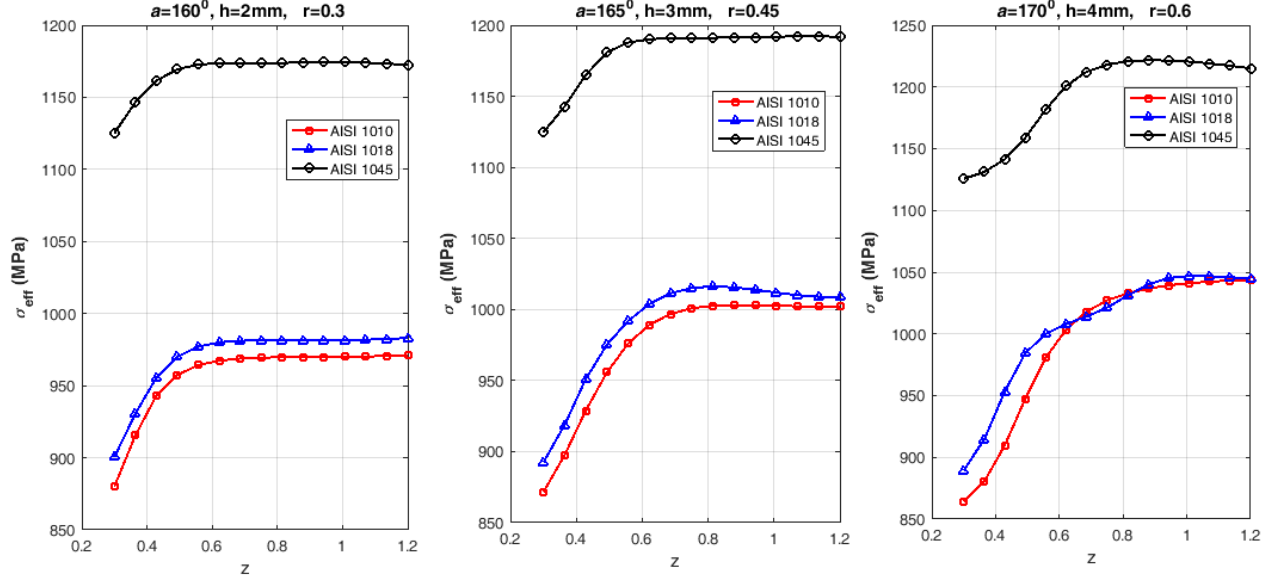
Figure 8. Comparison of forming response: effective stress.